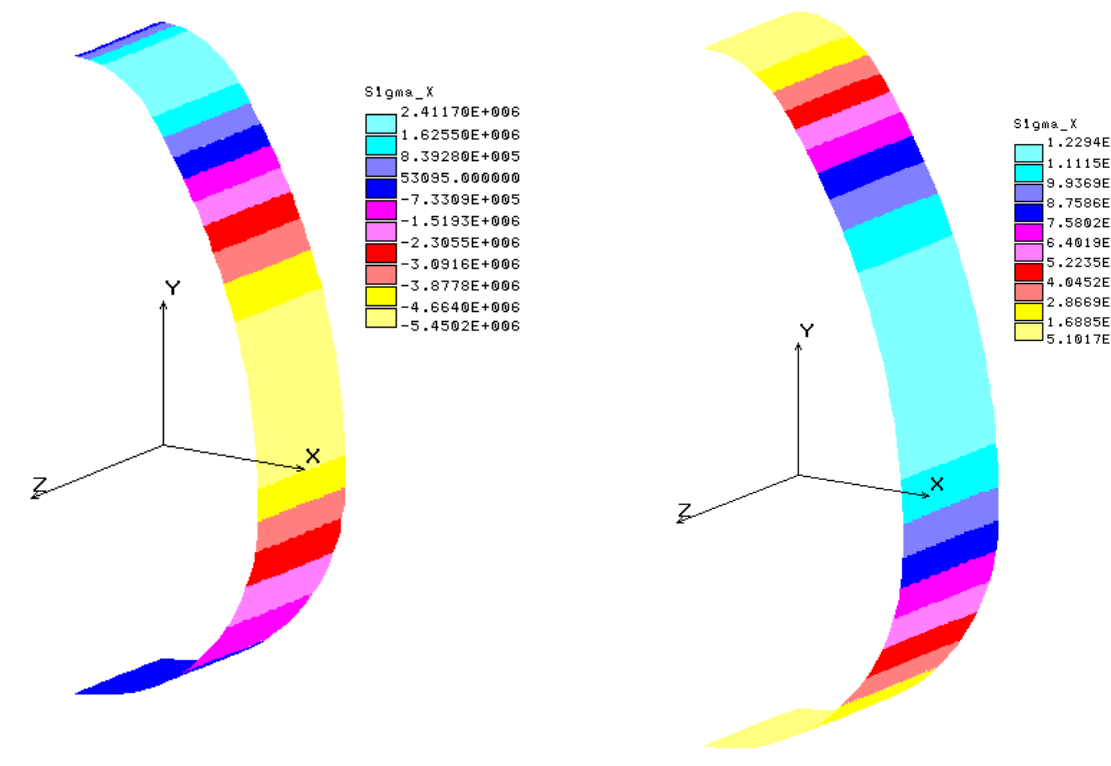
Figure 5: Normal stresses (load scheme 2 – wall thickness equal to 41